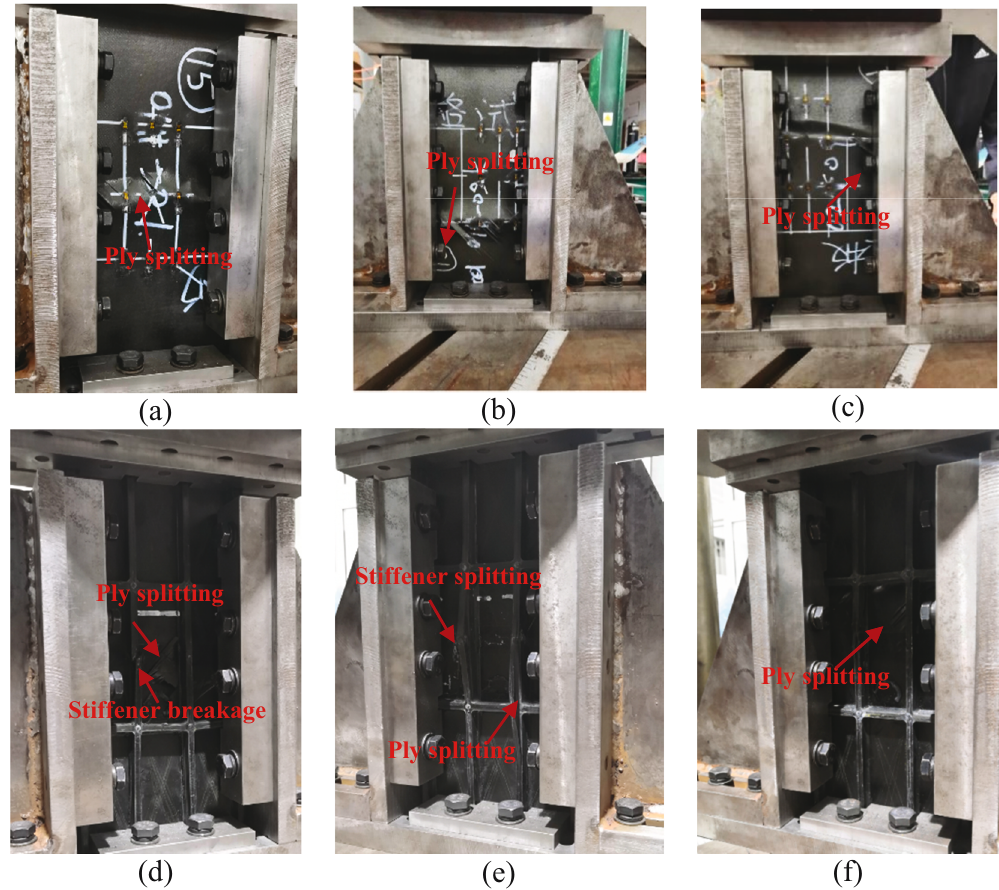
Figure 10: Compression damage of the specimen after aging for 0 days: ( a and d ) #2; ( b and e ) #3; and ( c and f )